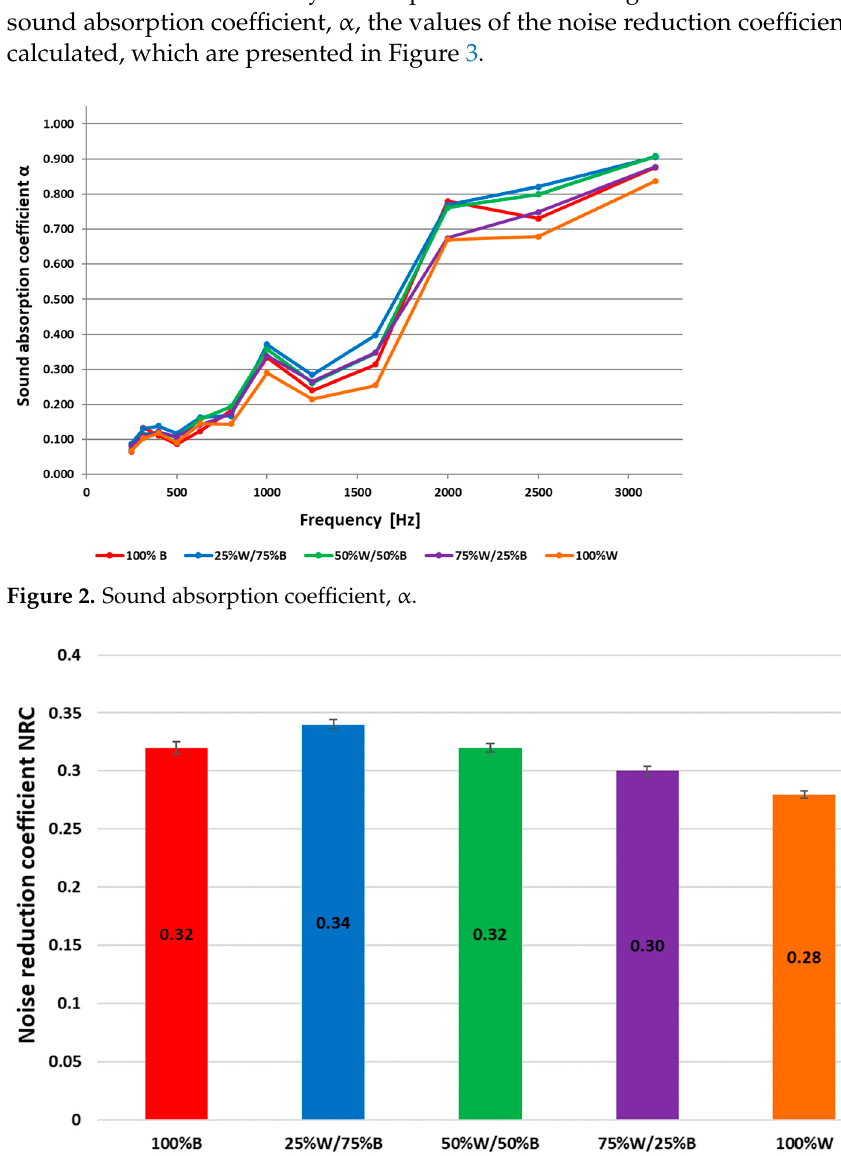
Figure 3. Noise reduction coefficient, NRC.